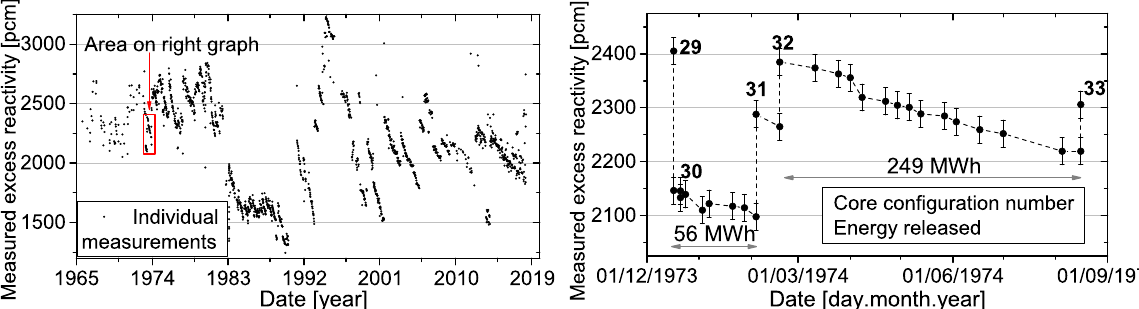
Figure 1: Measurements of excess reactivity performed at the JSI TRIGA reactor for the complete operational history (left) and selected period of 9 months (right), where four core configuration changes were employed in this period. Energy released during operation on core conf. No. 30 and 32 are